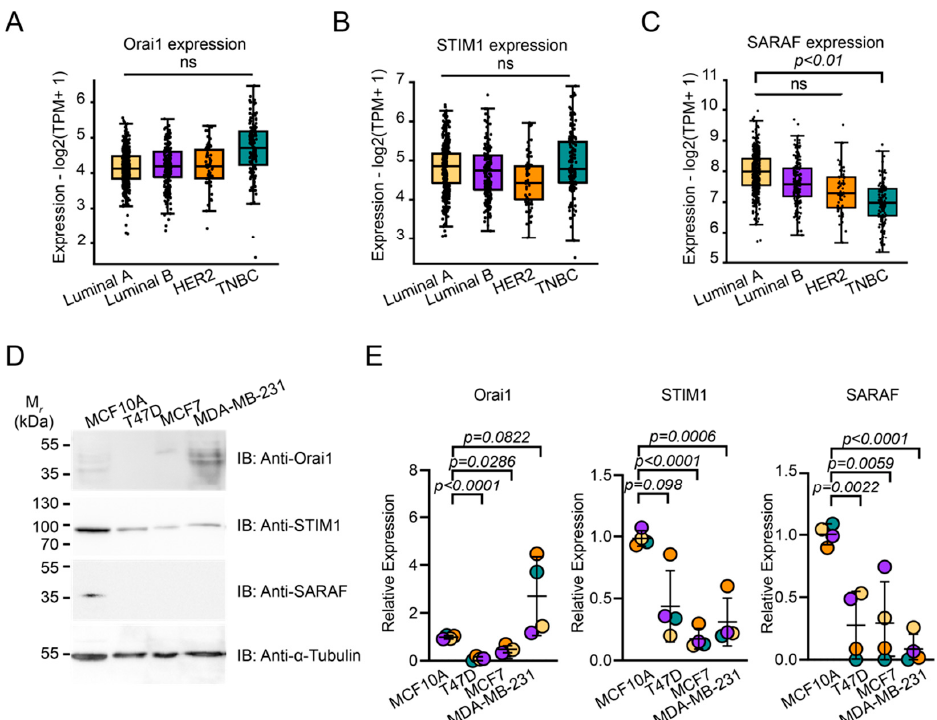
Figure 1. SARAF expression is diminished in triple-negative breast cancer. ( A – C ) GEPIA analyses from TCGA database. Relative transcript expression boxplot with jitter graphs of Orai1 ( A ), STIM1 ( B ) and SARAF ( C ) in different subtypes of breast cancer tumors. Each point represents individual human samples. Whiskers represent minimum (bottom) and maximum (upper) values. Number of human samples in luminal A (N = 415), luminal B (N = 194), HER2 (N = 66), and triple-negative cancer samples (N = 134). Statistical analyses correspond to ANOVA according to the GEPIA2 platform (available at http://gepia2.cancer-pku.cn. Accessed on 26 June 2022). ( D ) Immunoblot of protein expression of Orai1, STIM1 and SARAF in breast-related cell lines. ( E ) Relative expression of Orai1, STIM1 and SARAF related to α -tubulin levels (N = 4). Bars represent average expression levels. Error bars represent standard deviation. Individual points represent each experiment. Statistical analyses correspond to ANOVA followed by Dunnett’s multiple comparison